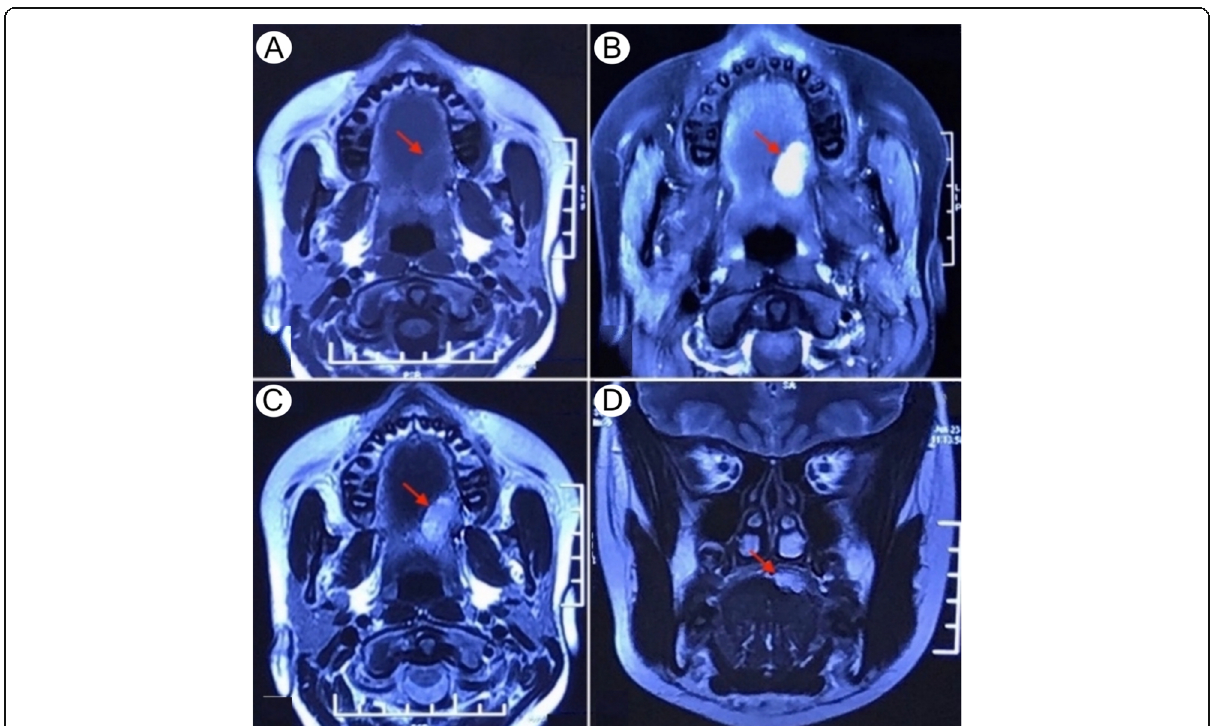
Fig. 2 CE-MRI face (coronal cuts a – c axial cuts d ) showing the tumor involving left side posterior tongue (red arrow). a The tumor is isointense on T1, b brightly and uniformly enhancing on contrast administration, and c heterogeneously hyperintense on T2